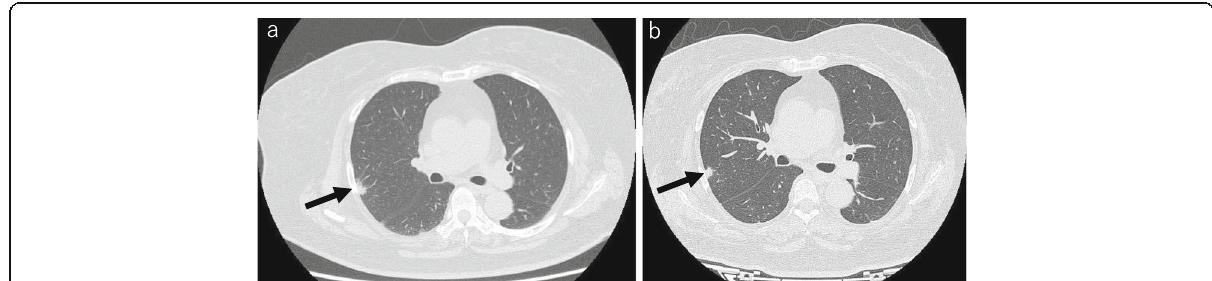
Fig. 1 Chest computed tomography scan. a An image obtained 1 month before the LSG is shown. A 10-mm mass was observed in the superior lobe of the right lung (arrow). b An image obtained 2.5 months after the LSG is shown. No marked change in the size of the lung mass (arrow) was noted, but a reduction in the amount of subcutaneous fat was seen